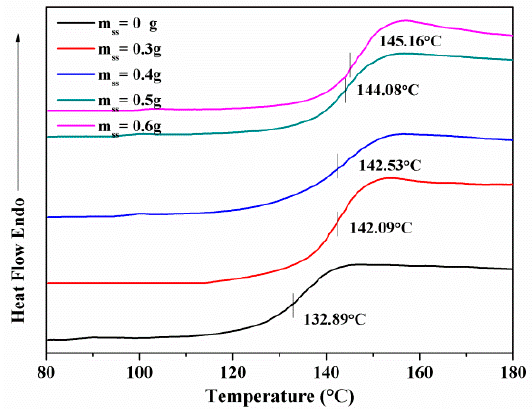
Figure 7. T g of IPN hydrogels.